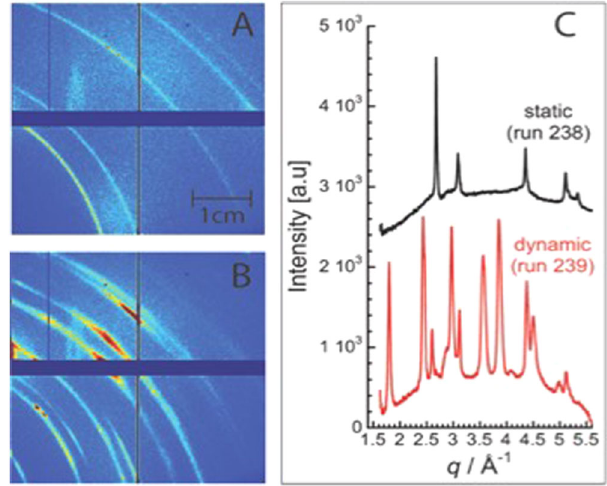
Fig. 3 X-ray diffraction data is shown for benzene before and after shockwave compression. Static ( A ) and dynamic ( B ) XRD patterns were collected on CSPAD detectors located x = 6 cm from the benzene sample. (color map corresponds to recorded intensity) Diffraction lines from polycrystalline Au coating are observed in the static image. C Upon shockwave compression to 55 GPa, diffraction lines are observed from crystalline products formed from shocked benzene. The integrated pattern (in arbitrary units) in ( C ) shows diffraction peaks at this condition ( P = 55 ± 5 GPa, T = 4940 ± 710 K). The color scale is relative intensity and is arbitrary to the CSPAD detector